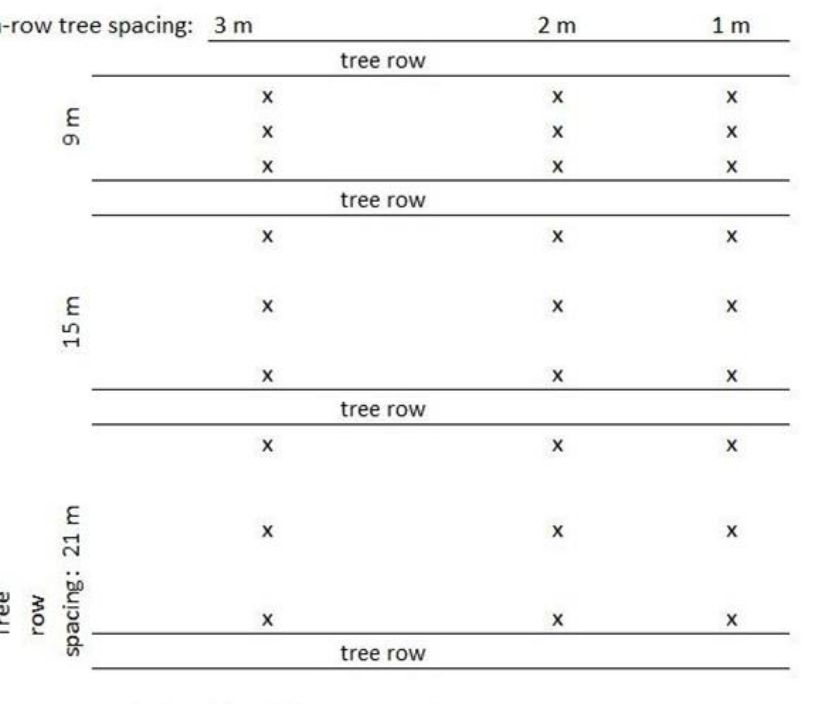
Table 7. Growing technology of triticale of the harvesting years 2018 and 2019.